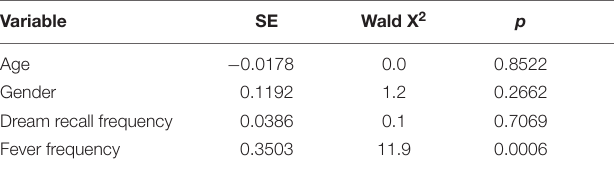
TABLE 2 | Factors affecting the report of a most recent fever dreams